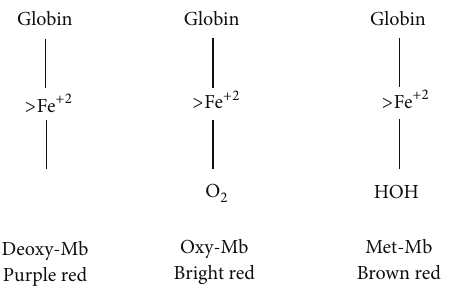
Figure 1: Colour of meat and associated forms of mioglobin [23]. During handling, processing and storage of fresh meat, released endogenous iron is partially responsible for the catalysis of lipid oxidation [25].